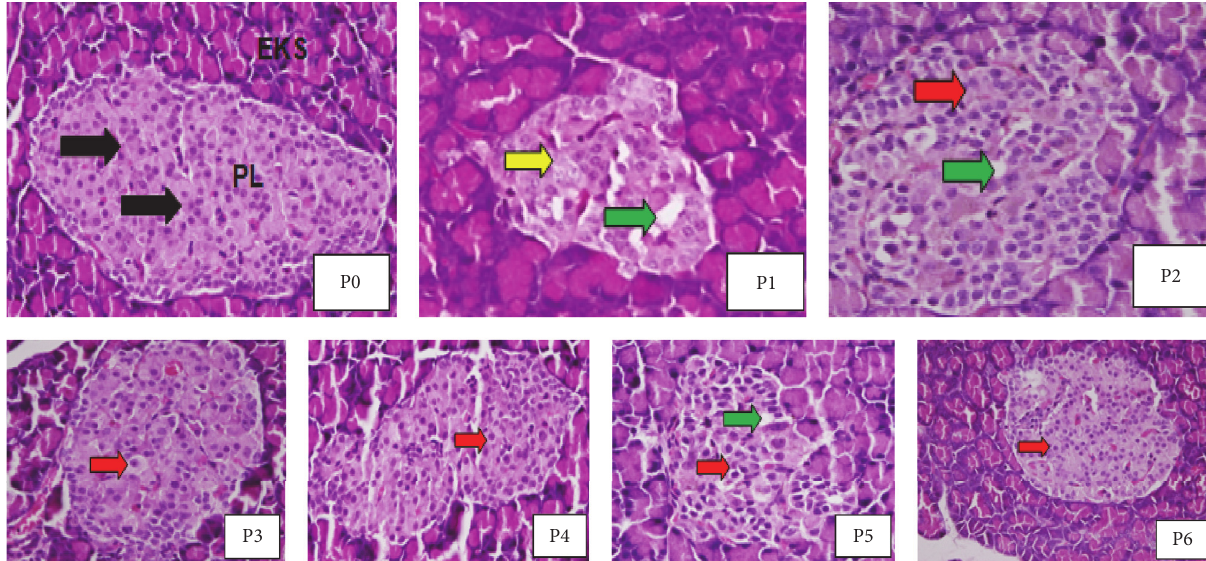
Figure 1: Histopathology of Langerhans islets of 𝛽 pancreas cells (400x magnifications). P0 = normal rats without STZ induction; P1 = STZ- induced diabetic rats with no salacca vinegar treatment; P3 = STZ-induced diabetic rats treated with Swaru salacca vinegar; P4 = STZ-induced diabetic rats treated with Gula Pasir salacca vinegar; P5 = STZ-induced diabetic rats treated with Madu salacca vinegar; and P6 = STZ-induced diabetic rats treated with Madura salacca vinegar. PL = Langerhans islets, EKS = exocrine glands, black arrow = normal cells, green arrow = empty room due to necrosis, yellow arrow = loss of nucleus, and red arrow = endocrine cells which started doing regeneration toward their normal configuration.